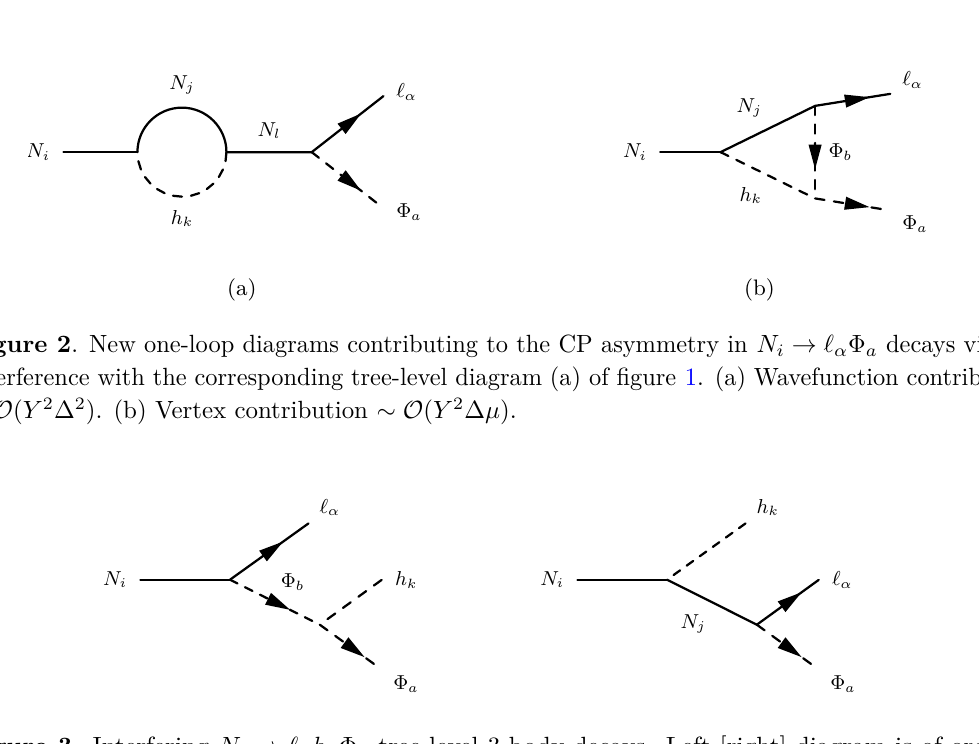
Figure 3 . Interfering N i → ‘ α h k Φ a tree-level 3-body decays. Left [right] diagram is of order ∼ O ( Y µ ) [ O ( Y ∆) ] in the